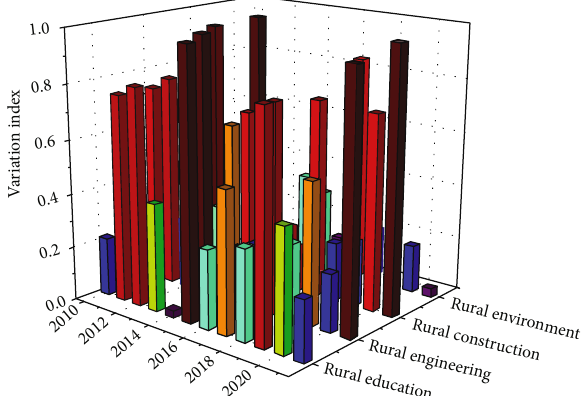
Figure 1: Annual progress of multimedia revitalization and e- commerce rural